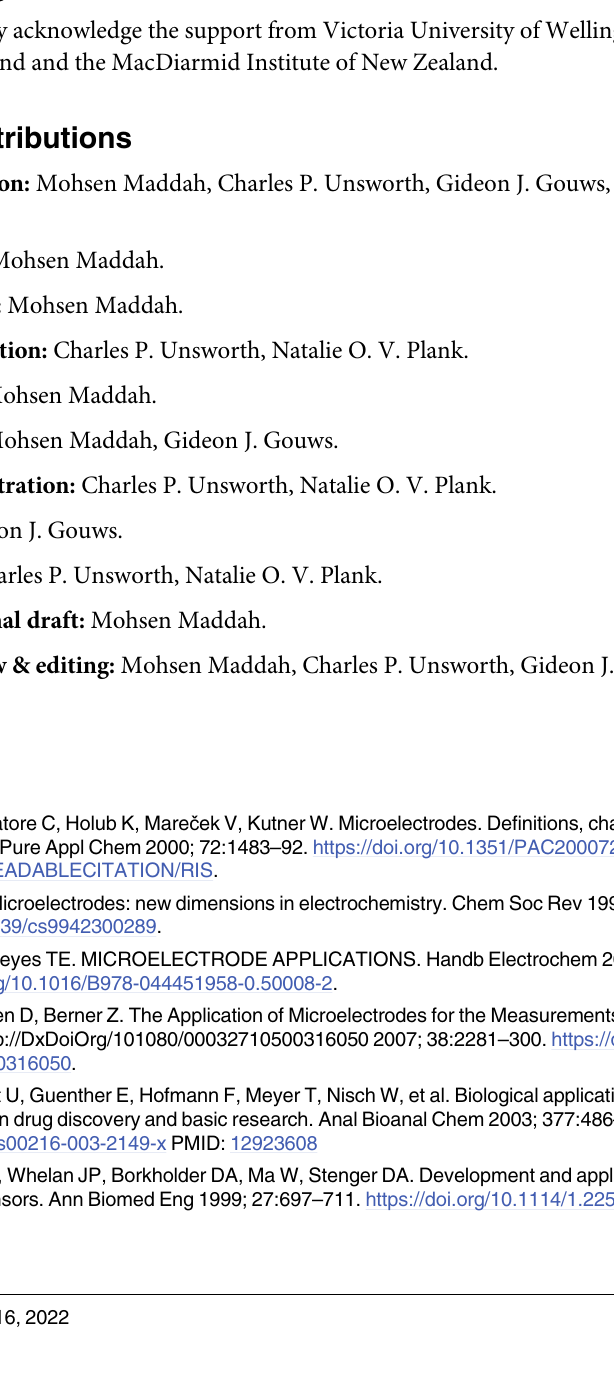
S1 Table. Literature comparison of nanomaterial microelectrodes. S2 Table. Impedance parameters of the microelectrodes. Parameters are measured by fitting the measured impedance (after the open/short circuit compensation) to the modified Randles equivalent